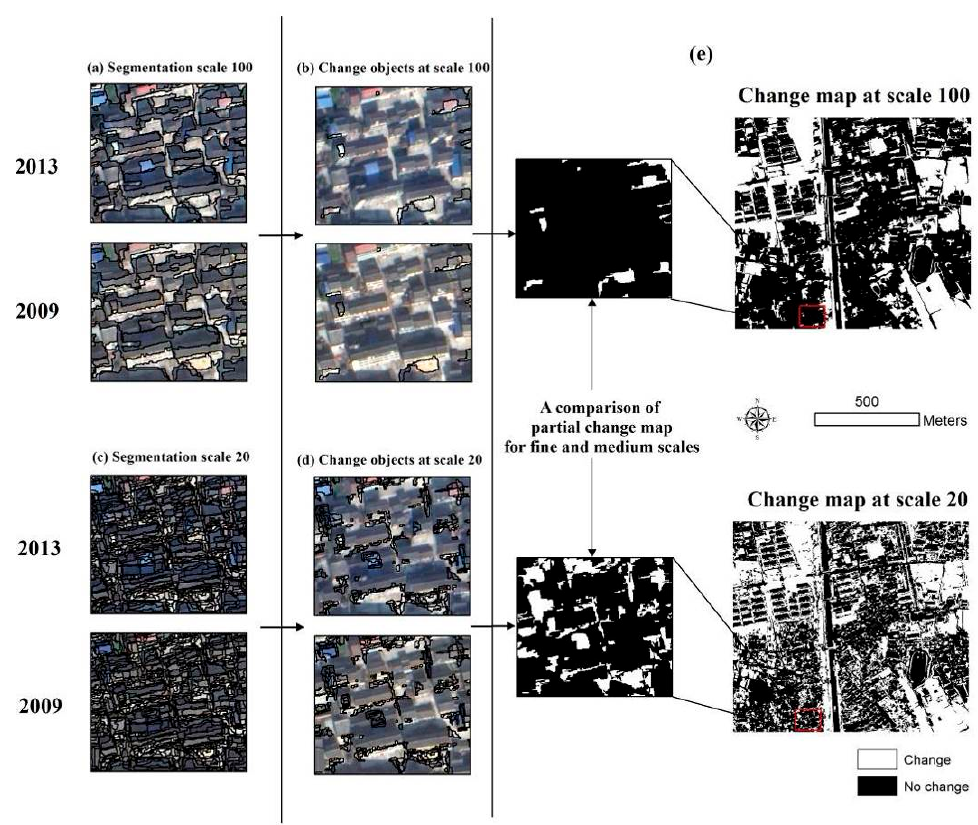
Figure 9. Change maps were produced for Study site 1 using the Multivariate Alteration Detection (MAD) method and segmentation Strategy 2; the segmentation scale was fixed at 20 or 100 to show the effect of “sliver objects”. ( a ) A example result of segmentation at scale 100; ( b ) Change objects detected for the segments of (a); ( c ) A example result of segmentation at scale 20; ( d ) Change objects detected for the segments of (c); ( e ) Change map at scale 20 and 100 respectively for area 1.